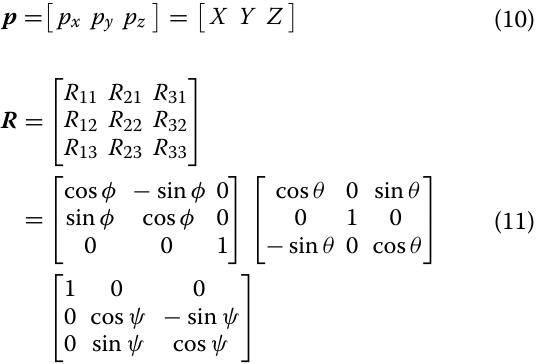
of the end-effector around the Y-axis (pitch), and ψ is the rotation of the end-effector around the X-axis (yaw).